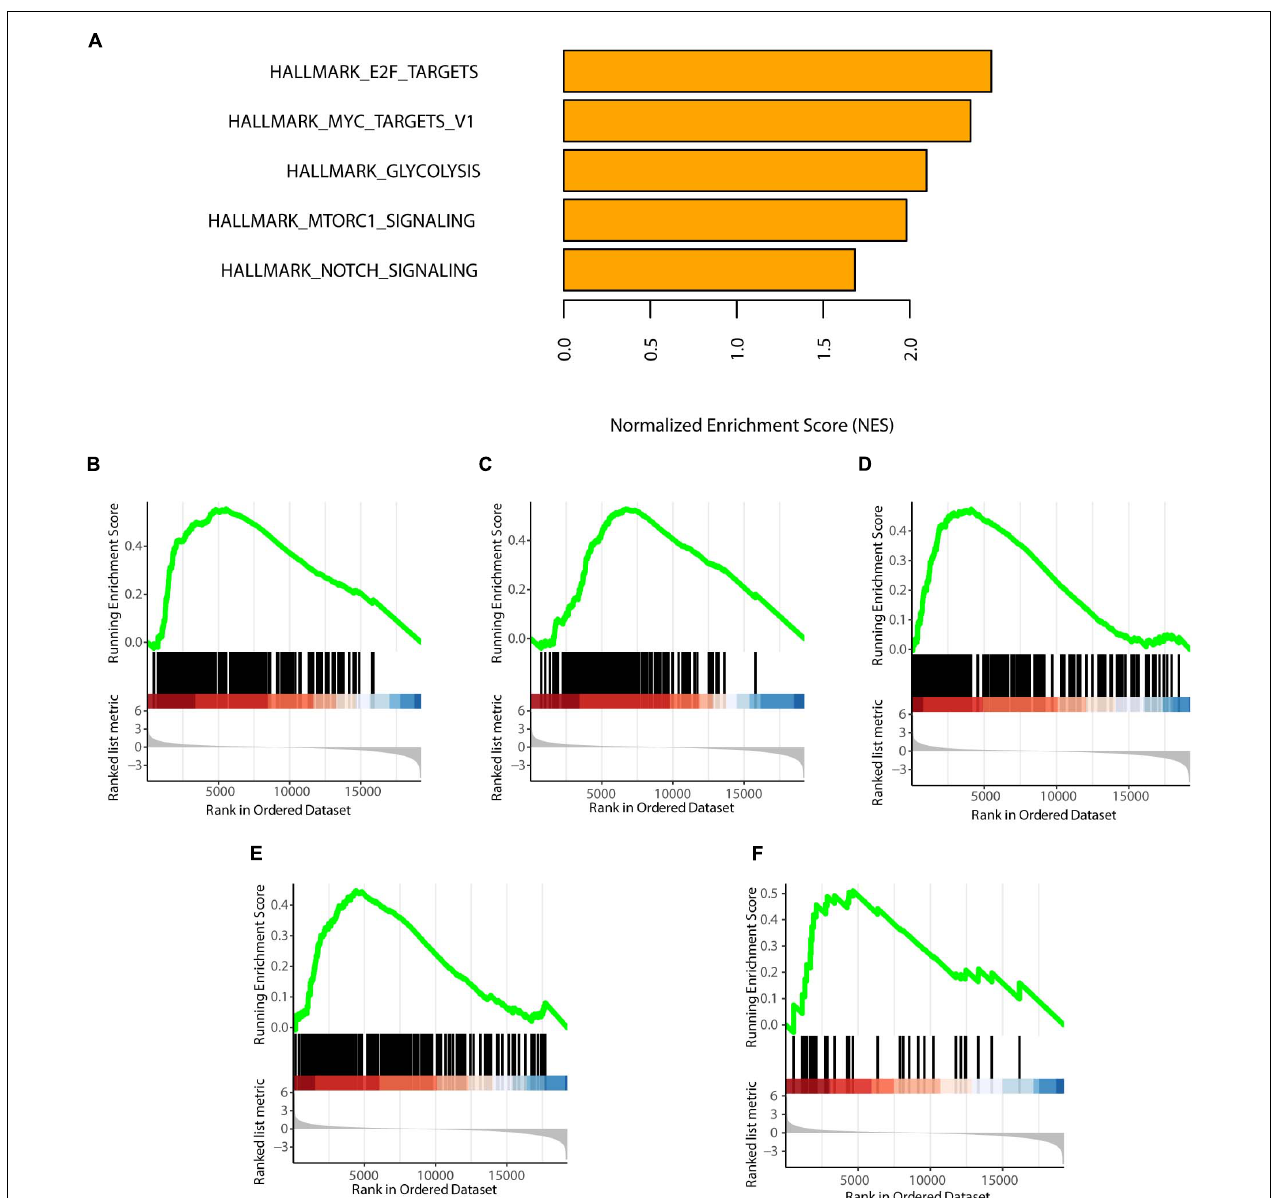
FIGURE 6 | GSEA of the two subtypes. (A) Top five enrichment terms (ranked in descending order of NES). (B) HALLMARK_E2F_TARGETS. (C) HALLMARK_MYC_TARGETS_V1. (D) HALLMARK_GLYCOLYSIS. (E) HALLMARK_MTORC1_SIGNALING. (F) HALLMARK_NOTCH_SIGNALING. NES: normalized enrichment scores. P < 0.05 was defined as statistically